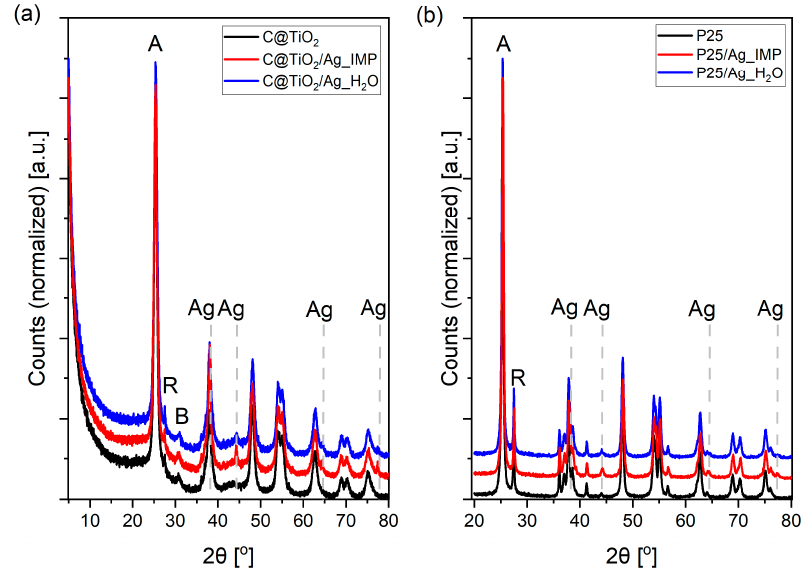
Figure 3. XRD patterns of C@TiO 2 ( a ) and P25 ( b ) materials before and after deposition of Ag using two different methods—IMP and H 2 O (A—anatase, R—rutile, B—brookite). It should be noted that the selected supports differ in the phase composition of TiO 2 .